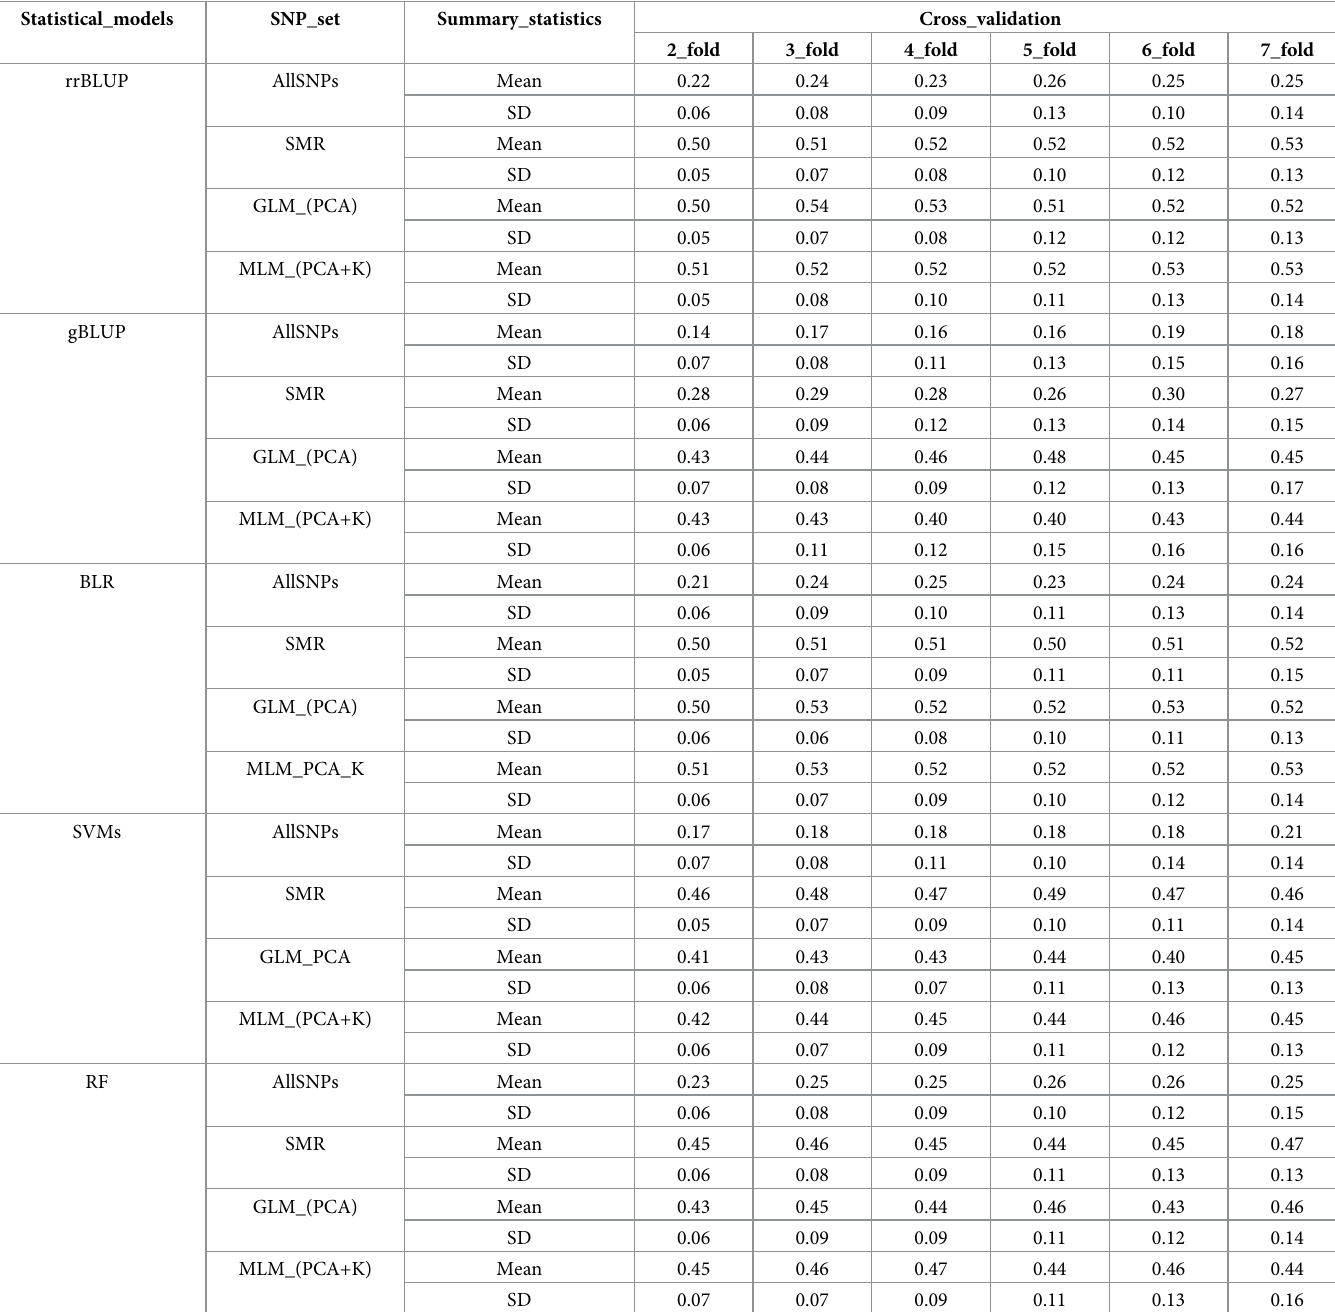
Table 6. Genomic selection accuracy of tolerance index based on biomass reduction under SCN infestation using 5 statistical models (rrBLUP: ridge regression best linear unbiased predictor, gBLUP: genomic best linear unbiased predictor, BLR: Bayesian Lasso regression, RF: random forest, and SVMs: support